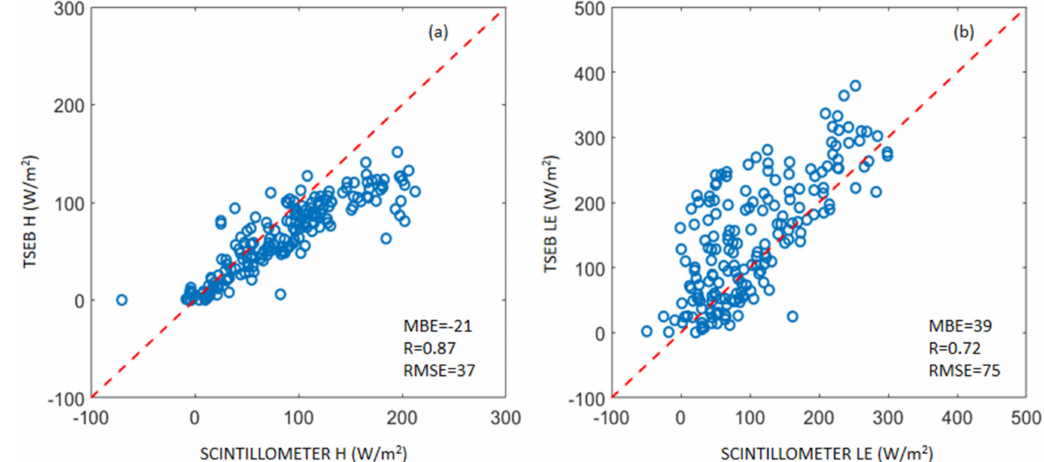
Figure 7. Sensible ( a ); and latent ( b ) heat fluxes scatterplots between LAS measurements and TSEB prediction fed by aggregated in-situ data (at 30 min